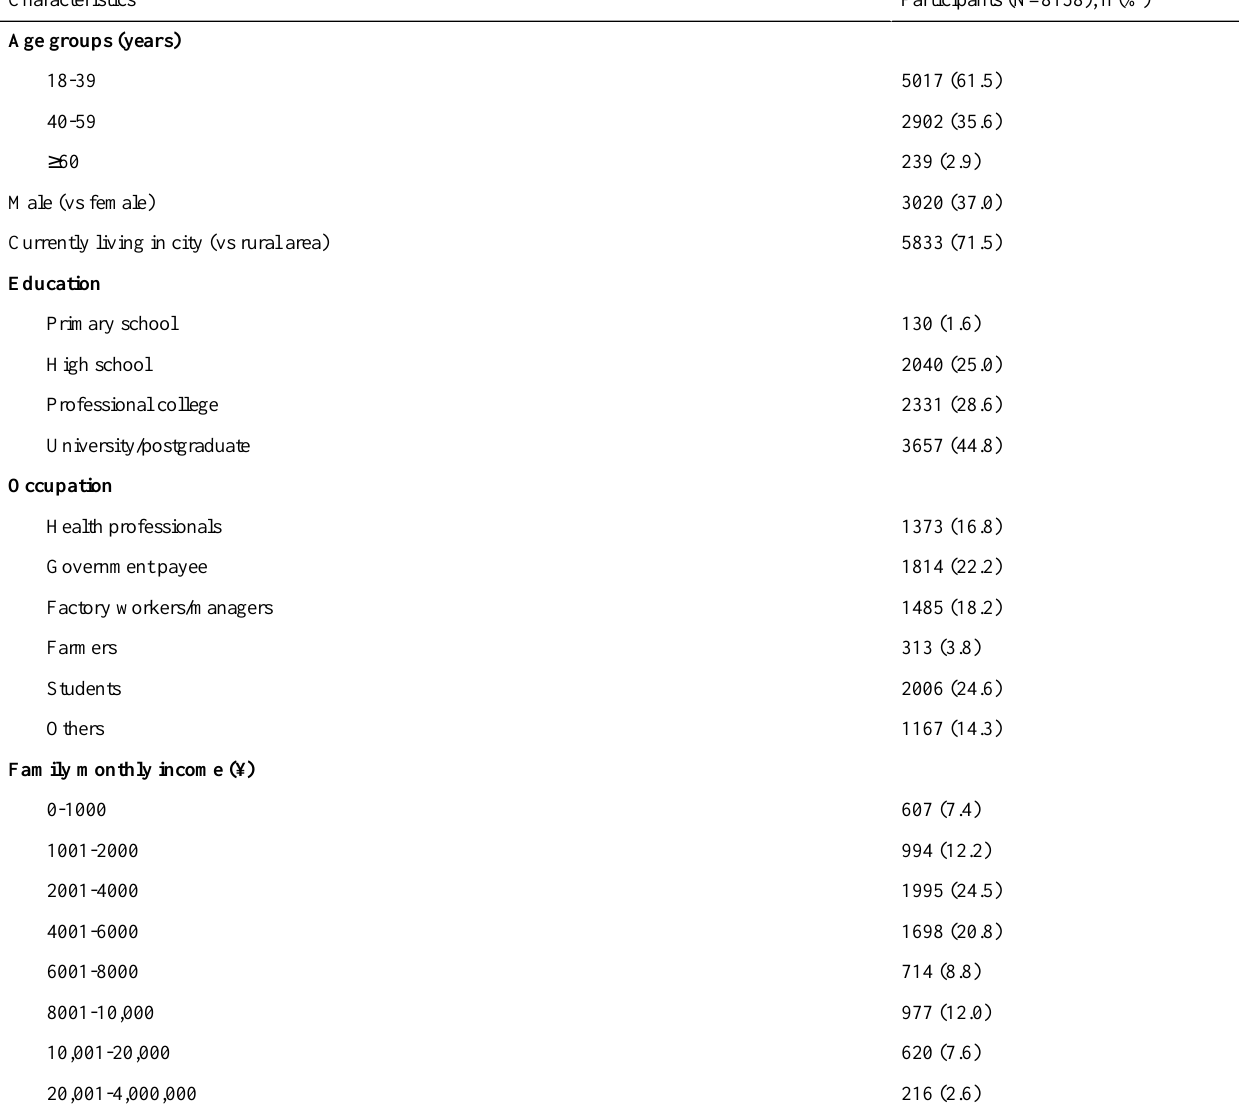
Table 1. The demographic characteristics of the study